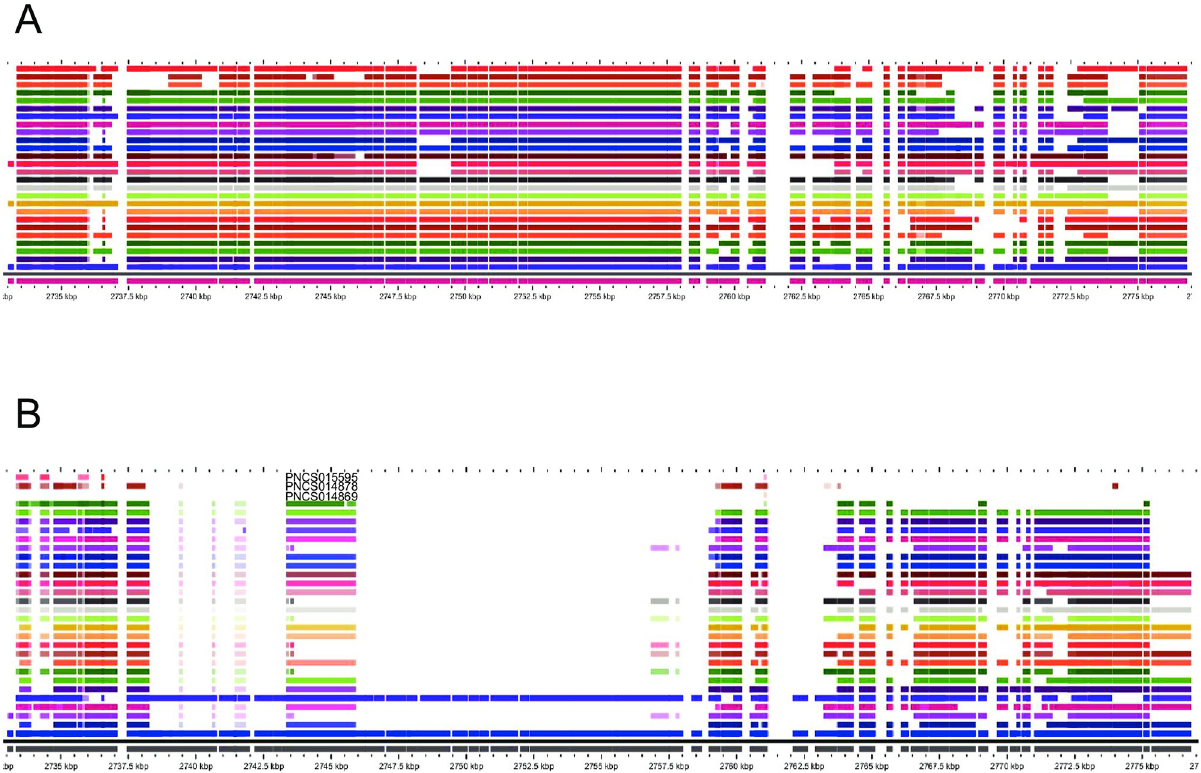
Fig 7. Variability of the Gifsy-1 prophage in S. Typhimurium and Salmonella 4,[5],12:i:- isolates. A. Example of normal variability seen in the population. B. Compilation of all genomes with large deletions within Gifsy-1. Isolates were compared using pangenome analysis with GView server.